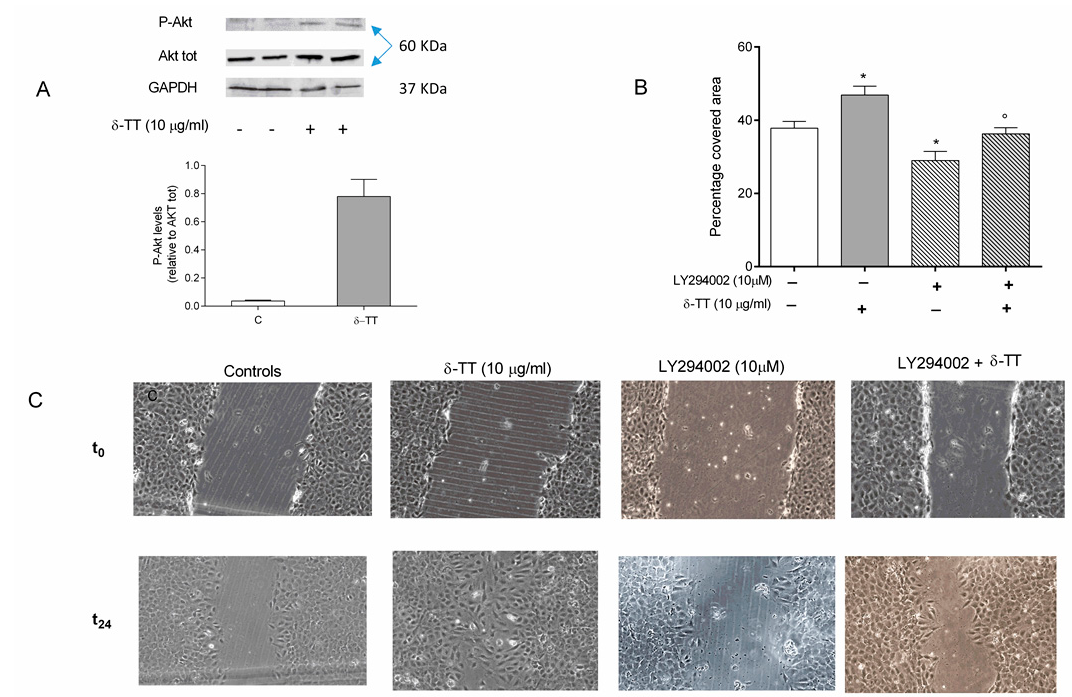
Figure 5. Involvement of PI3-K / AKT pathway in the wound healing e ff ect of δ -TT (10 µ g / mL) on MC3T3-E1 cells. ( A ) Cells were pretreated with δ -TT for 24 h, proteins were collected and levels of Akt phosphorylation (Ser473) and of total Akt were analysed by Western Blotting. Densitometer analysis of the bands was performed with ImageLab 4.0 provided by Biorad. We have reported a ratio between Phospho Akt / Akt total densitometer analysis. ( B , C ) pretreatment with LY294002 (10 µ M), a PI3-K antagonist, removes the wound healing e ff ects of δ -TT. Cells were incubated with LY294002 1 h min before treatment with δ -TT. The Wound healing assay was performed as detailed in Figure 2. The data are presented as the mean ± SEM of three independent experiments. * p < 0.05 vs. controls; ◦ p < 0.05 vs. δ -TT.